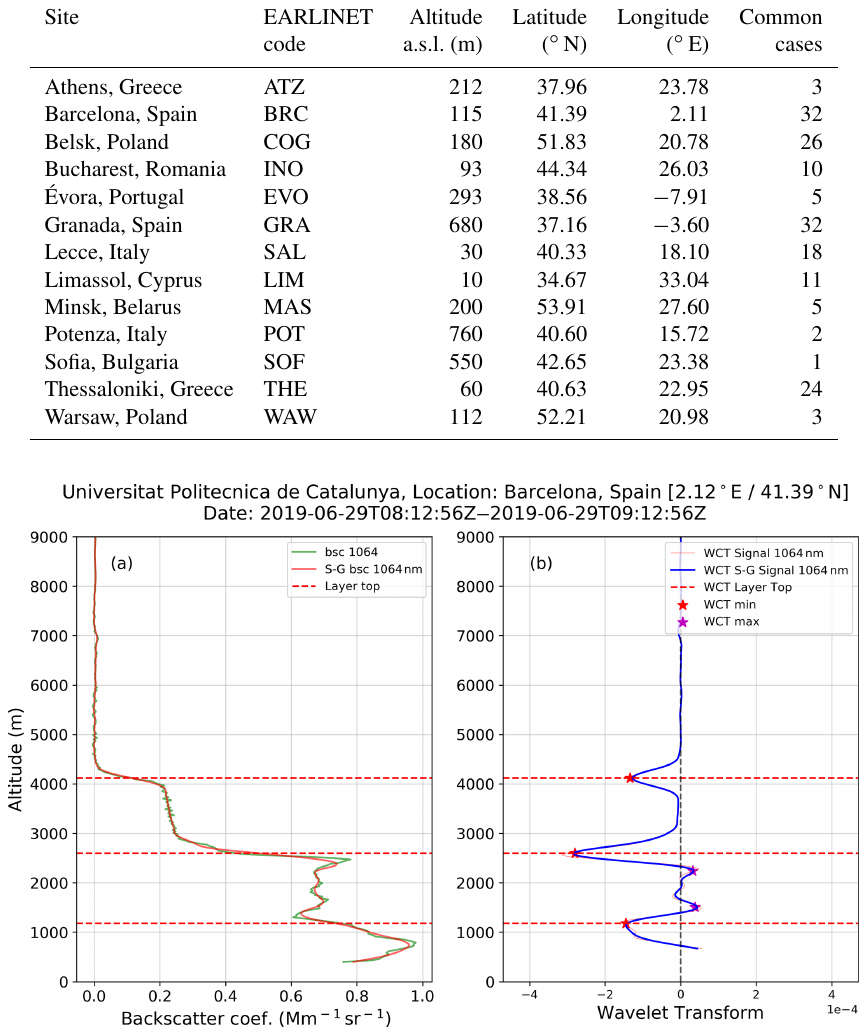
Figure 2. Barcelona lidar station (Universitat Politechnica de Catalunya, Barcelona – UPC): (a) lidar backscatter profile at 1064nm and (b) resulting WCT profile on 29 June 2019. The horizontal dashed red line represents the detected aerosol layer top applying the WCT methodology. The label “S–G” indicates that a Savitzky–Golay filter was used to reduce to noise variance in the backscatter profile. The coloured “star” symbols represent the local maxima (purple) and minima (red) of wavelet transform